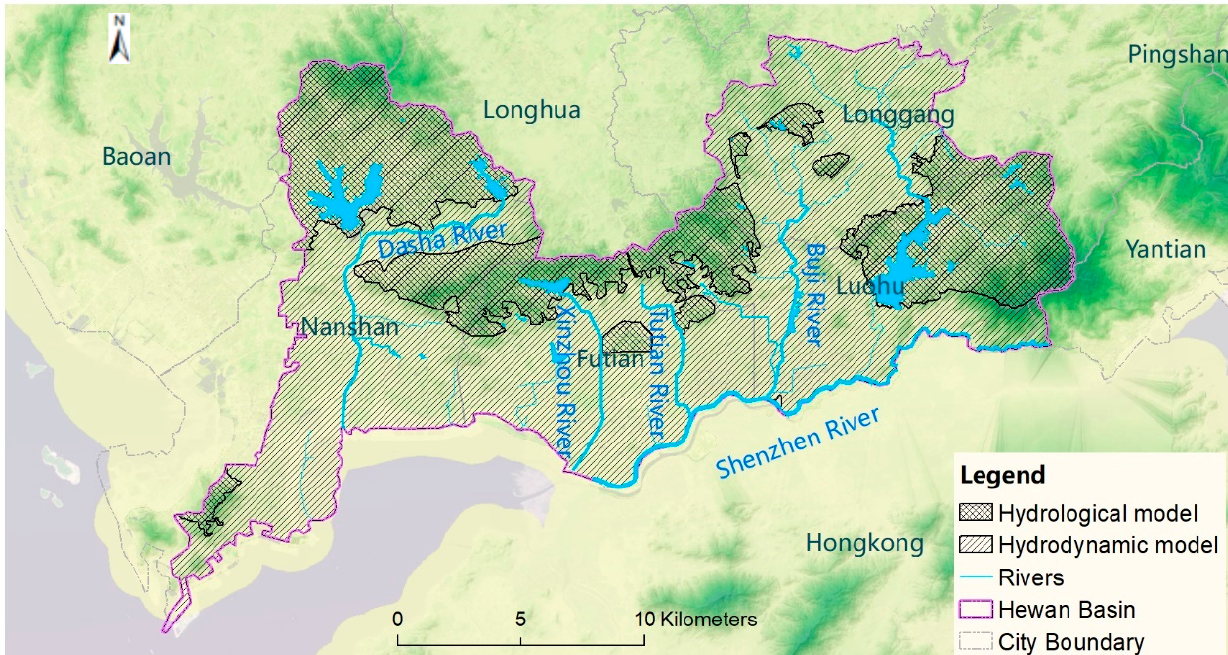
Figure 7. Distribution map of hydrological and hydrodynamic models.